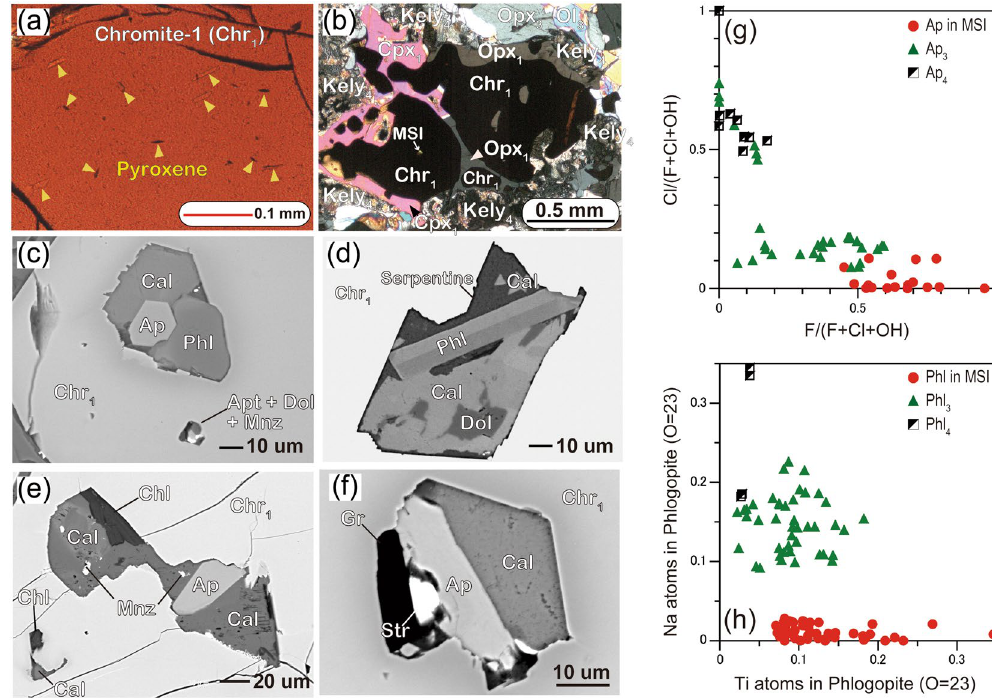
Figure 4. Panel (a) is a photomicrograph of a chromite grain (Chr 1 ) containing pyroxene lamellae, indicating the former presence of chromite (Chr 0 ) that grew under ultrahigh-pressure (UHP) conditions in the diamond stability field during Stage 0 12 , plane polarized light. Subscript numbers represent crystallization stages of minerals. Panel (b) shows aggregates of chromite (Chr 1 ) + orthopyroxene (Opx 1 ) + clinopyroxene (Cpx 1 ) formed from UHP Chr 0 by a recrystallization under the Stage 1. They are surrounded by kelyphite (kely 4 ) of Stage 4. The matrix consists mainly of Stage 3 olivine (Ol 3 ) and orthopyroxene (Opx 3 ), cross polarized light. Panels (c) and (d) show back-scattered electron (BSE) images of multiphase solid inclusions (MSIs) consisting of phlogopite (Phl), calcite (Cal), dolomite (Dol) and apatite (Ap). Panels (e) and (f) show BSE images of MSIs consisting of Cal, Dol and Ap. Mnz = monazite, Str = strontianite, Gr = graphite, Chl = chlorite. Panel (g) is a diagram of F/(F + Cl + OH) versus Cl/(F + Cl + OH) in Ap occurring as MSIs in Chr 1 , matrix Ap 3 and Ap 4 - proximal kelyphite. Panel (h) is a diagram of Ti versus Na contents in Phl from MSIs within Chr 1 , matrix Phl 3 and Phl 4 -proximal